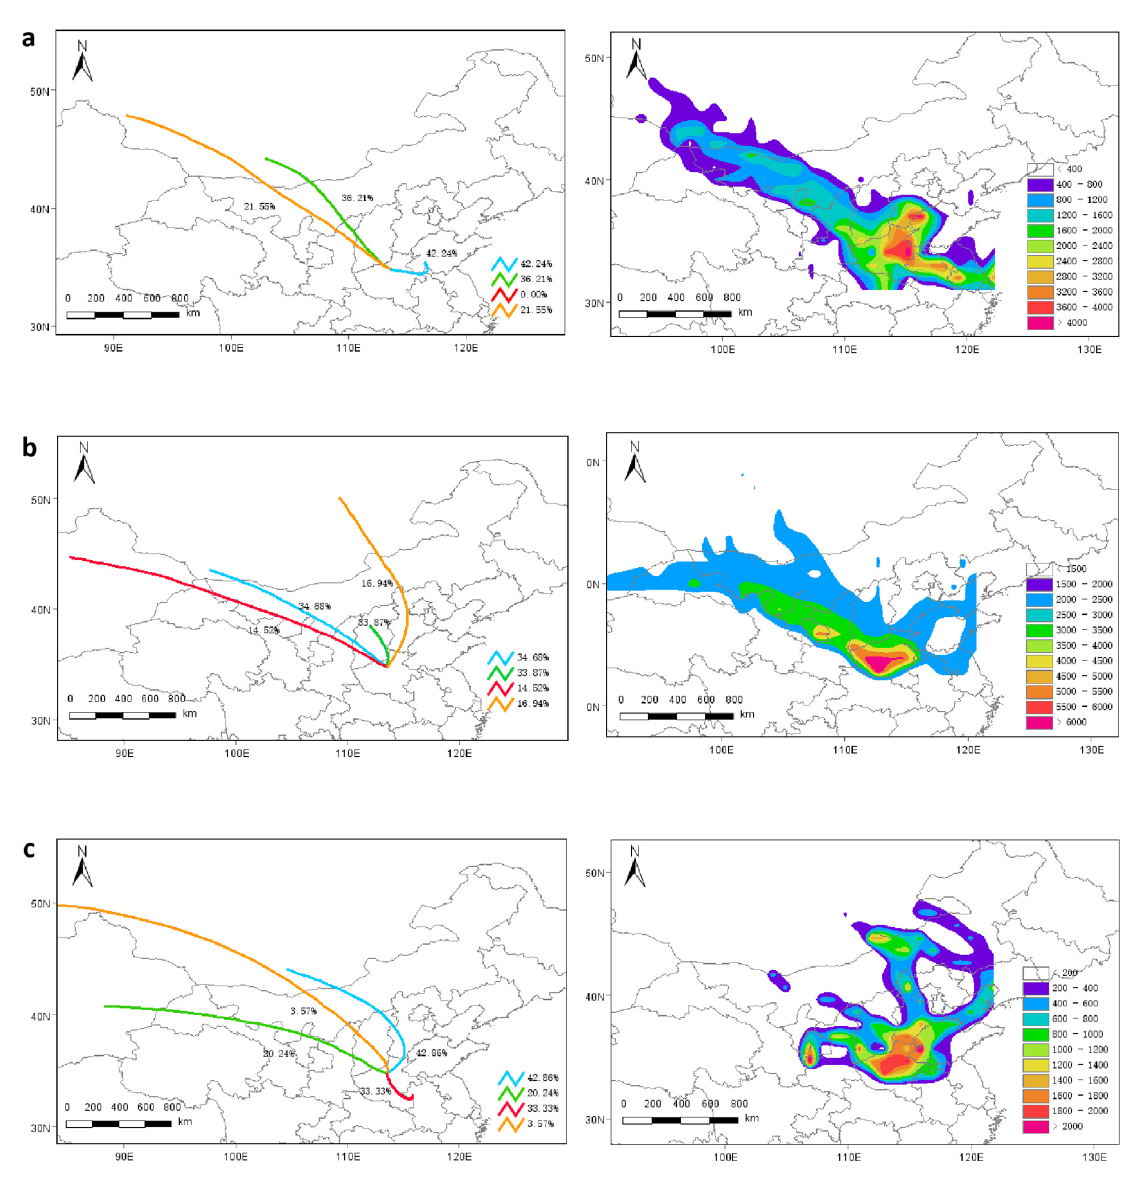
Figure 10. Results of the back-trajectory cluster analyses and concentration weighted trajectory during November 2021 ( a ); December 2021 ( b ); and March 2022 ( c ).